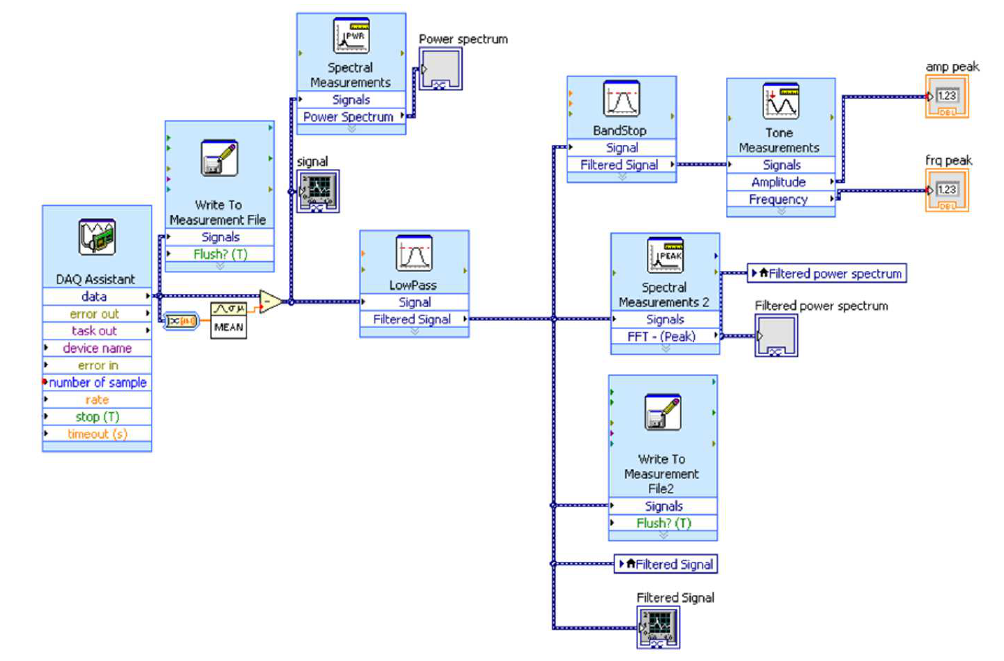
Figure 10. The Labview schematic that implements signals acquisition and analysis modules Soft Sensor